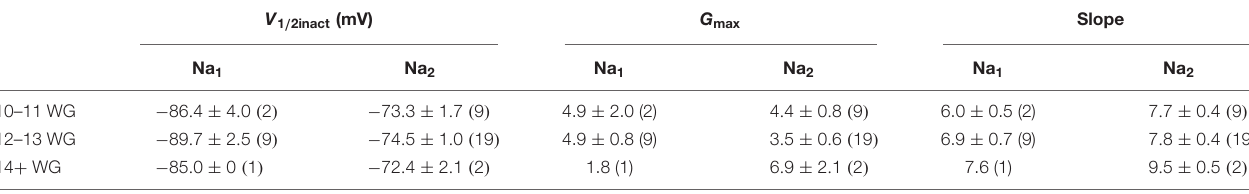
FIGURE 5 | Na + currents in fetal vestibular hair cells. (A) The mean Na + current amplitude recorded from vestibular hair cells in three age groups, 10–11 WG, 12–13 WG, and 14+ WG. Scatter of individual Na + current amplitudes for each cell in each age group is shown. (B) Activation and inactivation plots for Na + currents for three age groups. (C) Left panel: a representative example of a Na + current from hair cell aged 12 WG in control L15 media (black trace) and in the presence of TTX (1 µ M; red trace). (C) Right panel: the I–V plot for the cell shown in (C) left panel in control solution (black trace) and in 1 µ M TTX (red trace). (D) Left panel: a representative example of a Na + current from cristae hair cell aged 11 WG in control L15 media (black trace), in the presence of TTX (1 µ M; red trace), and in the presence of both TTX and cadmium (300 µ M; purple trace). The Na + current was evoked by stepping from − 120 to − 20 mV. (D) Right panel: the I–V plot for the cell shown in (D) left panel in control solution (black trace), 1 µ M TTX (red trace), and 300 µ M cadmium (purple trace). (A,B) Mean and SEM are shown. TABLE 5 | V 1 / 2 inactivation, G max , and slope values for Na + currents in response to inactivation protocol. V 1 / 2inact (mV)